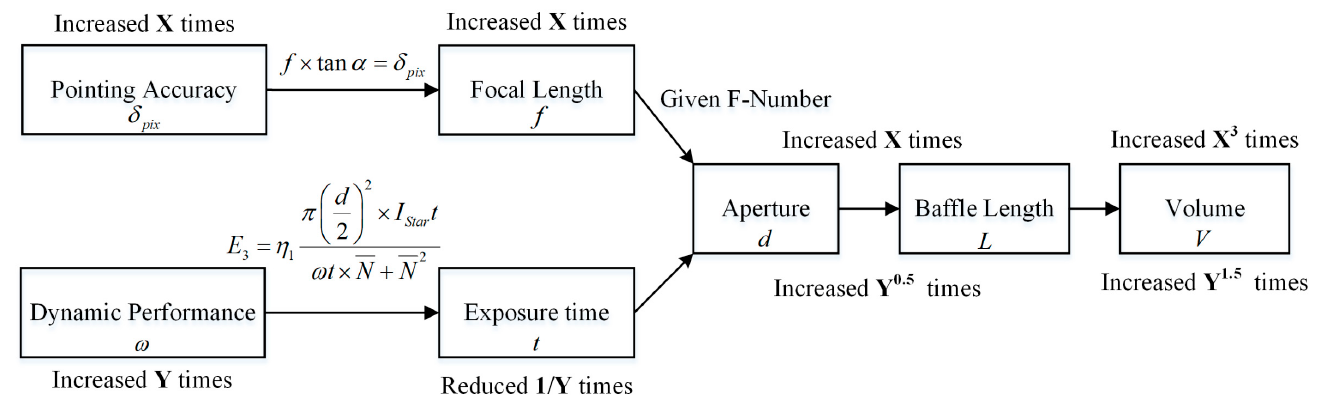
Figure 6. The volume relationship between pointing accuracy and dynamic performance.